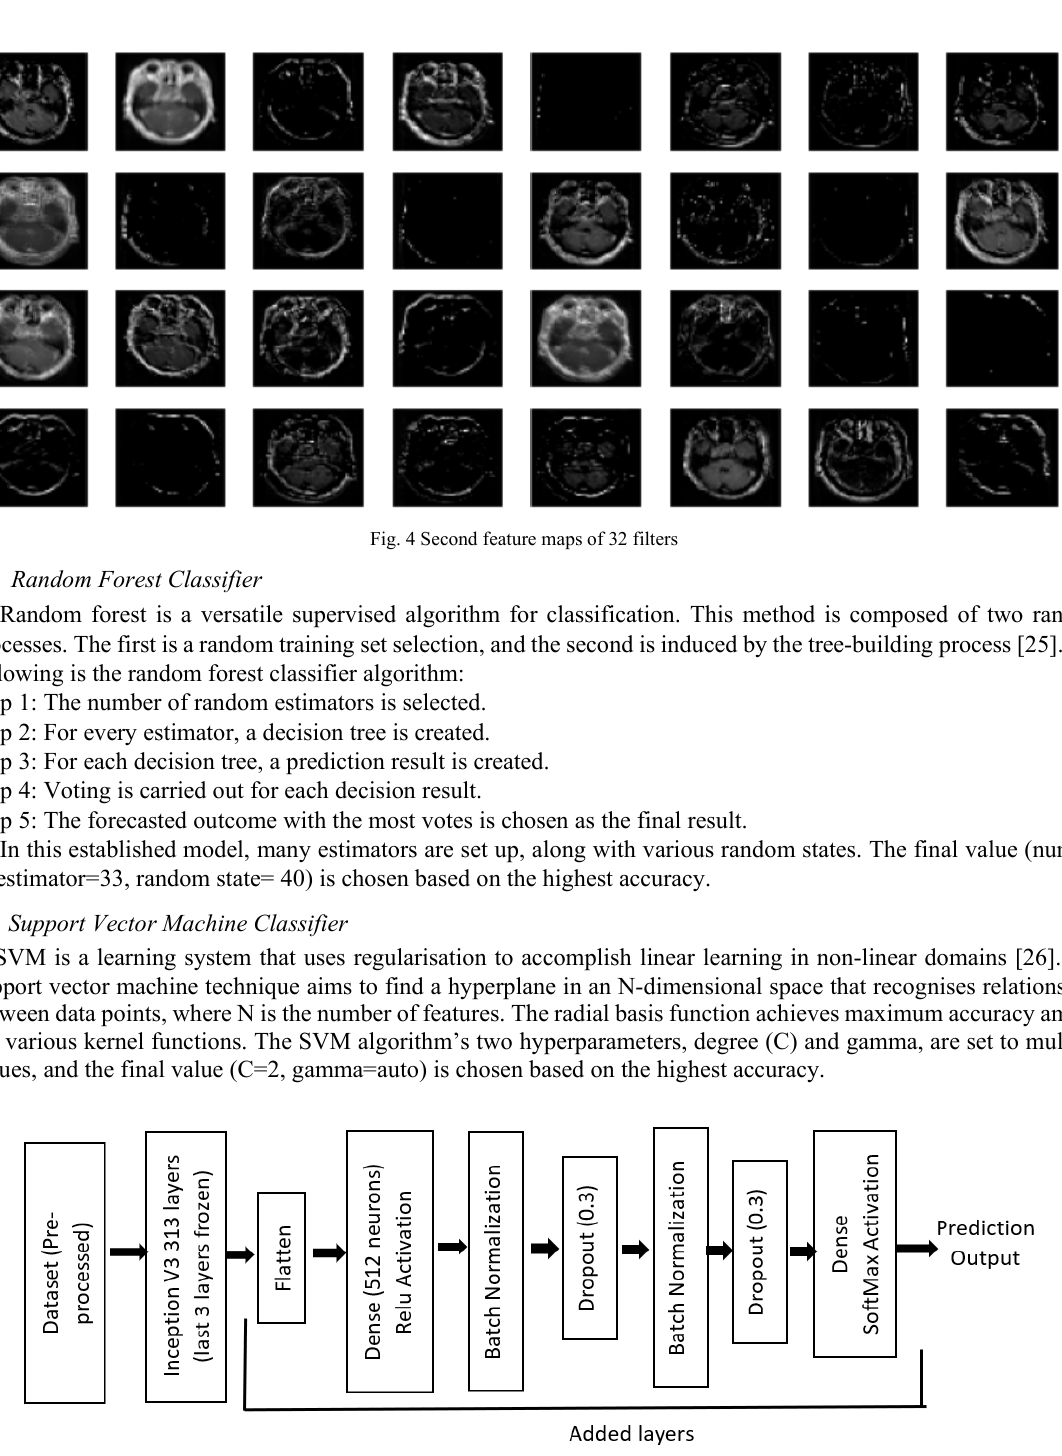
Fig. 5 Added layers in the inception V3